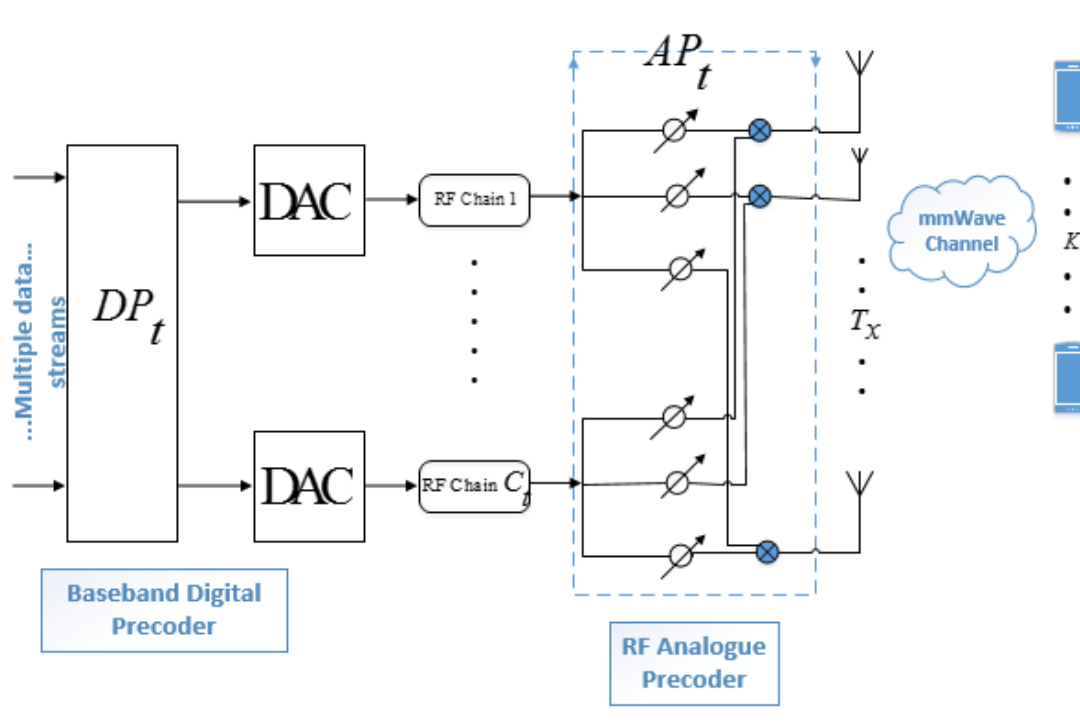
Figure 1. Conventionally used RF circuit configuration of mmWave Massive MIMO.